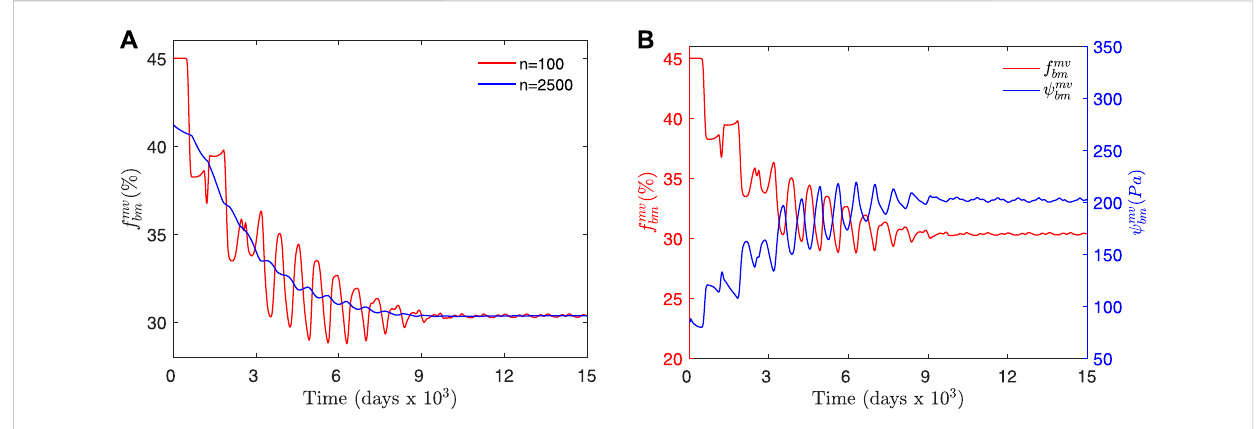
FIGURE 5 (A) Temporalevolutionof f mv bm (%)fortwodifferenttimewindows ofthemovingaverage.First,theaverage f bm isadaptedtotheappliedloadandthen stabilizedtoreachahomeostaticsituationwithsmalloscillations. (B) Temporalevolutionof f mv bm (%)and ψ mv bm (Pa),bothaveragedforatimewindow n =100. This evolution corresponds to the compression load case with an initial random distribution of f bm ∈ [10,